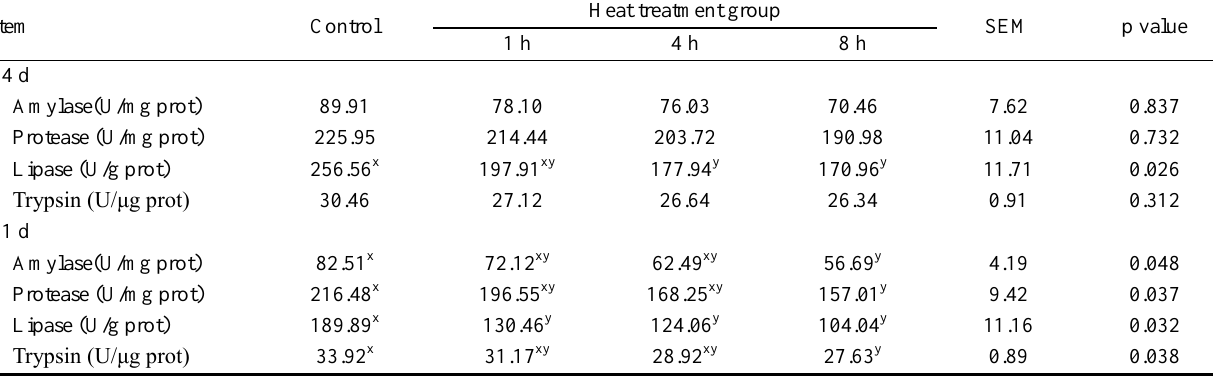
Table 5. Effects of heat-oxidized soy protein isolate on digestive enzyme activities within anterior intestinal contents of broilers